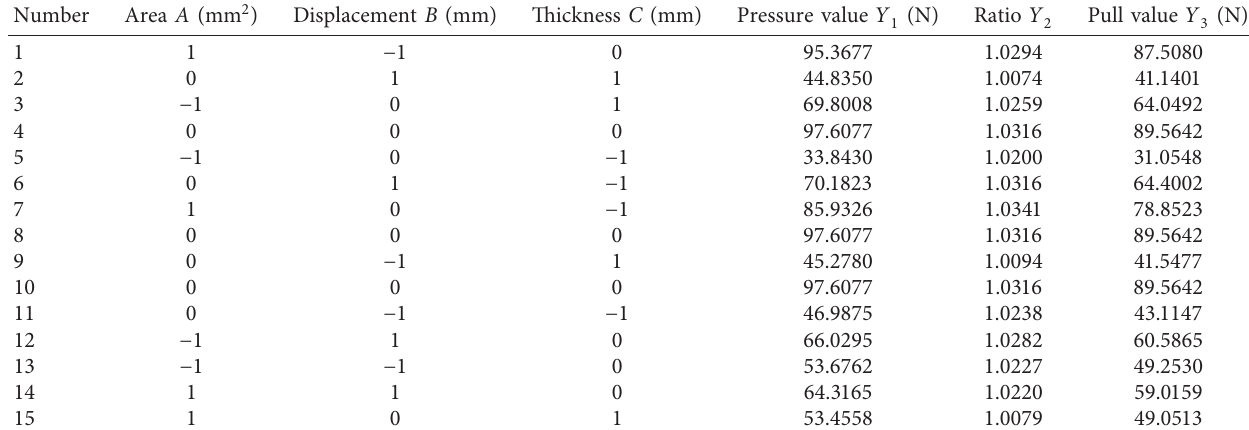
Table 3: Design and results of Box–Behnken test.